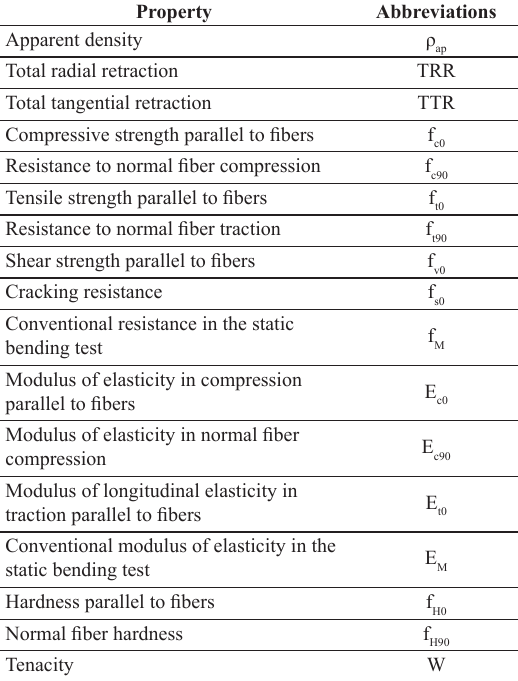
Table 2. Physical and mechanical properties